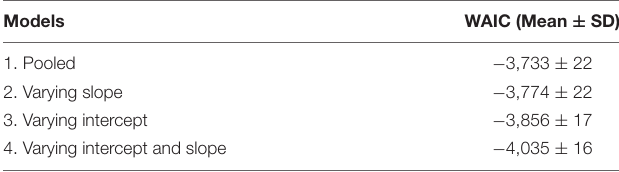
TABLE 3 | Models’ fitness of absolute positional